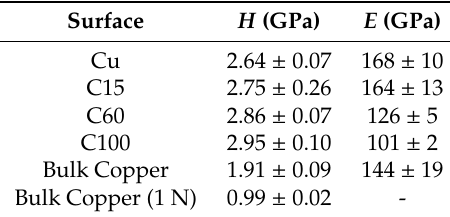
Table 4. Hardness ( H ) and Young’s modulus ( E ) of the deposited surfaces and bulk